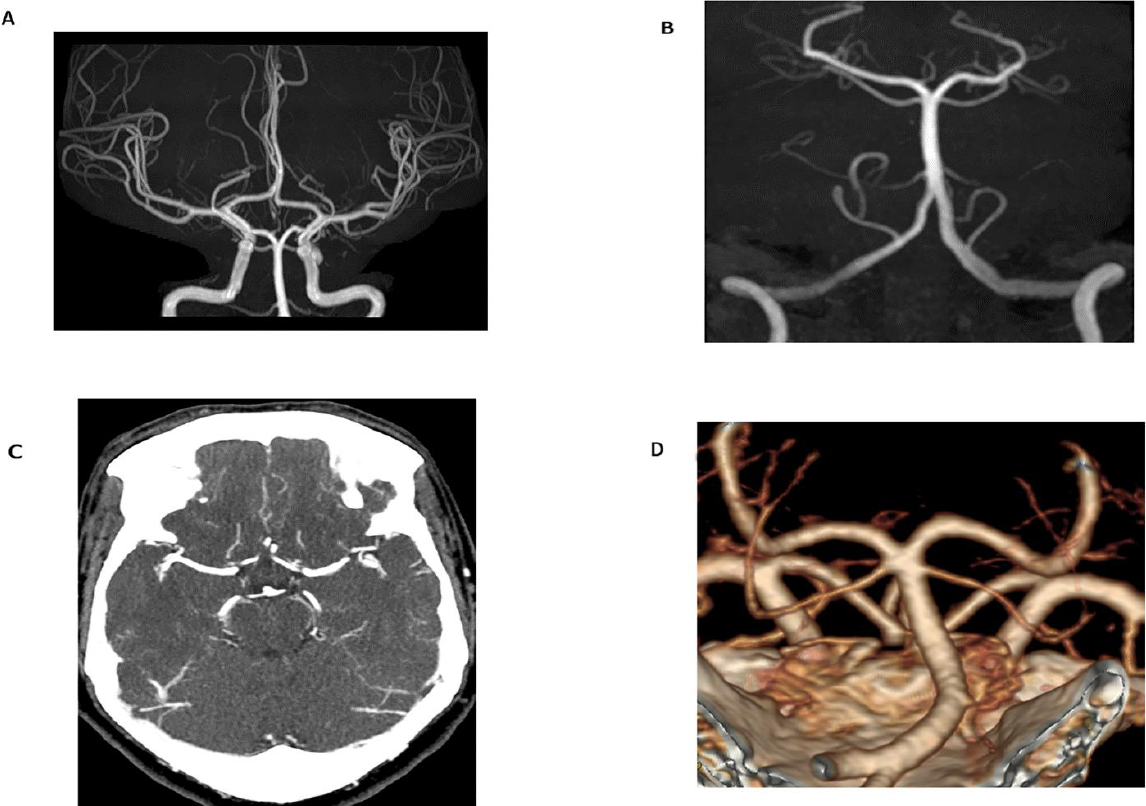
Figure 1. Time-of-flight (TOF) maximum intensity projection (MIP) image of the Circle of Willis ( A ) and basilar artery ( B ) in a 24-year-old female obtained for migraines and dizziness. The magnetic resonance angiogram (MRA) demonstrated no flow-limiting stenosis or occlusion. Additionally, imaging was performed without radiation or intravenous contrast (technical specifications: FOV 200.00 mm, TR 25 ms, TE 3.5 ms, 3 T magnetic field strength). In comparison to TOF-MRA, axial CT angiogram (CTA) MIP images ( C ) and volume-rendered images ( D ) in a 60-year-old female obtained for evaluation of tinnitus demonstrated no flow-limiting stenosis or occlusion. 100 mL of Omnipaque 350 contrast was administered and the CTDIvol for the CTA of the head and neck was 59.6 mGy.